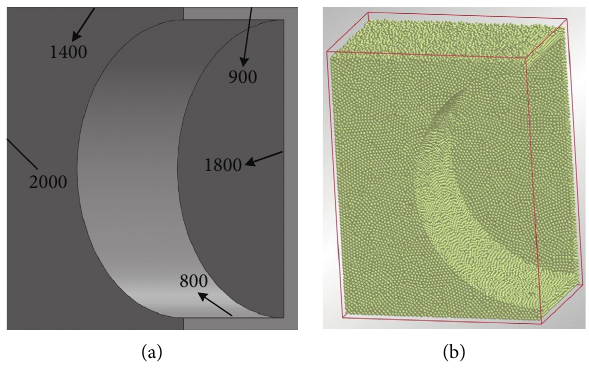
Figure 5: Coal seam model. (a) Size. (b) Particle filling